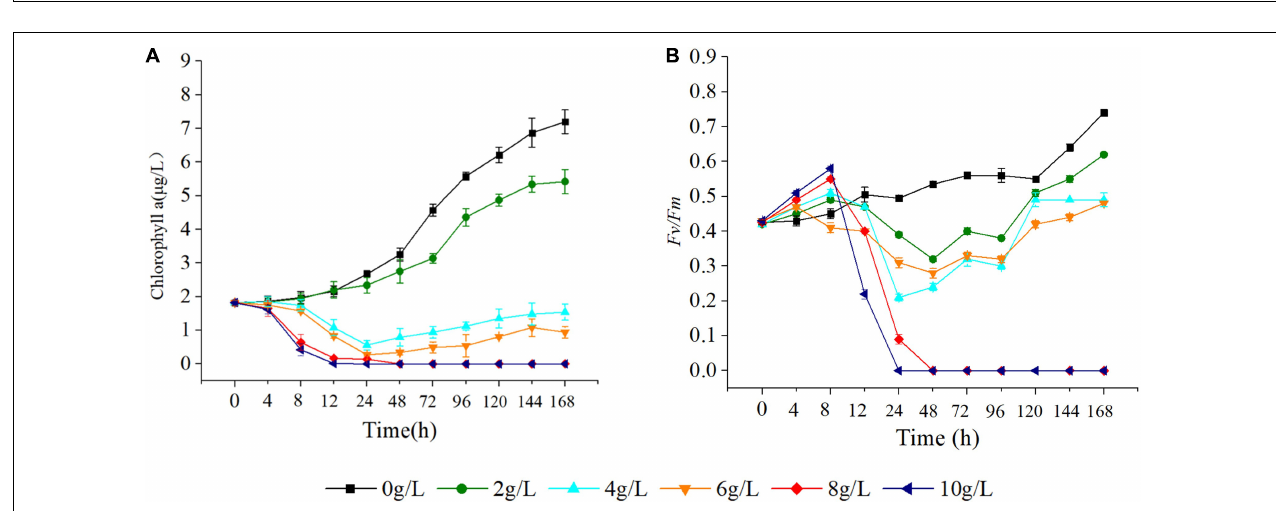
FIGURE 6 | Growth of Skeletonema costatum cultured at different concentrations of hijiki extracts for 96 h (20 × objective lens). (A) Control; (B) extract concentration of 4 g/L; (C) extract concentration of 8 g/L; (D) extract concentration of 10 g/L.